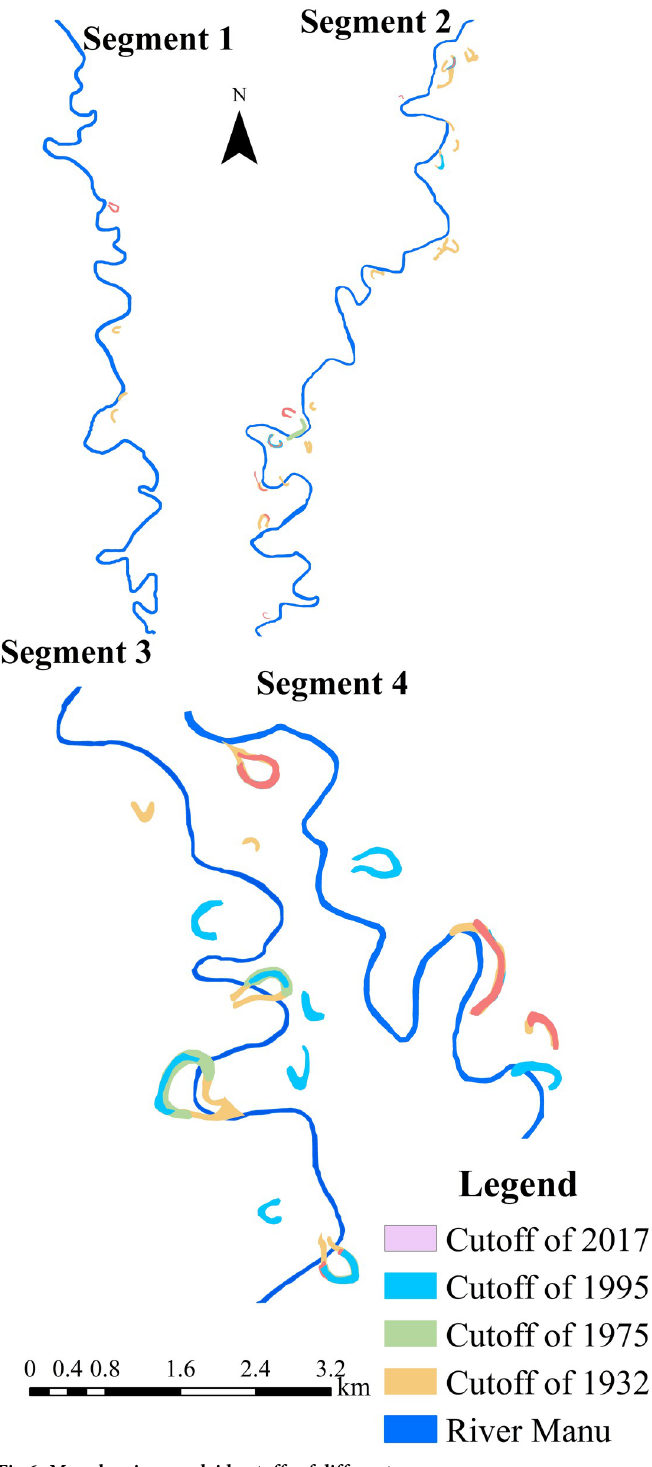
Fig 6. Map showing overlaid cutoffs of different years.